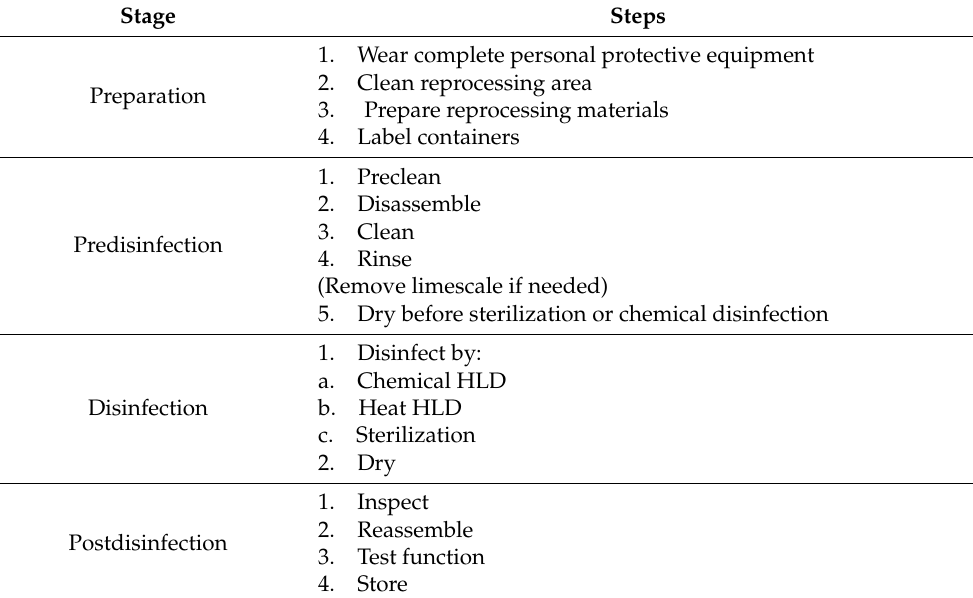
Table 3. Reprocessing steps according to the PATH guideline